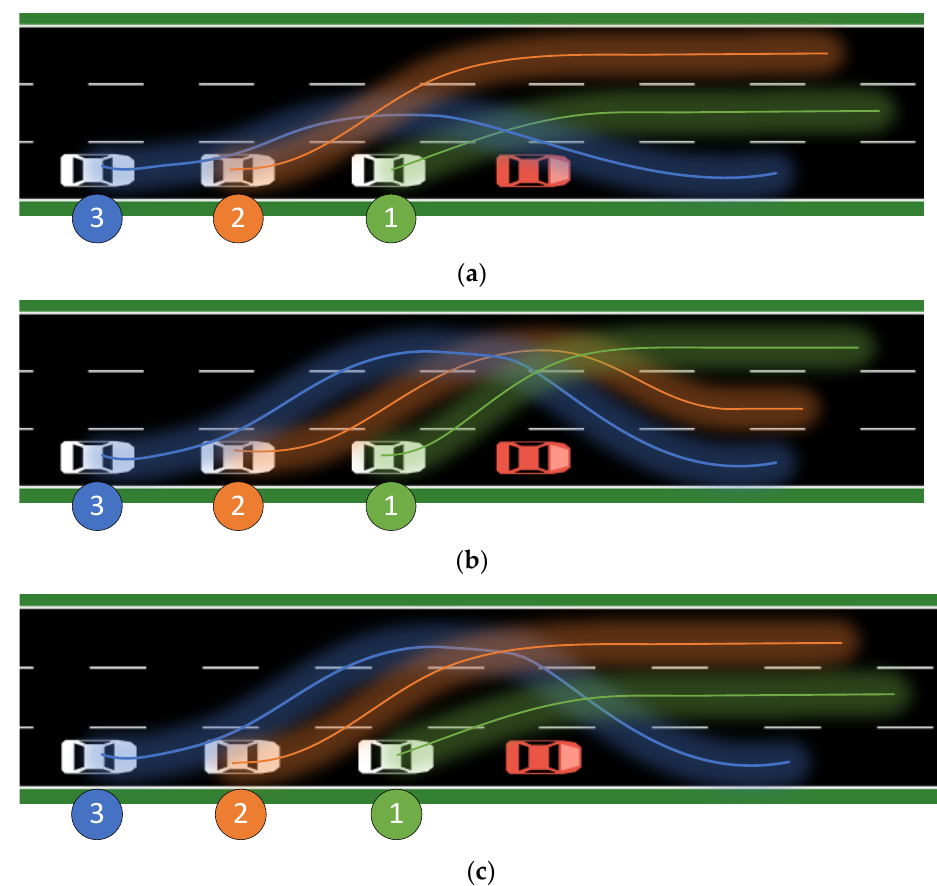
Figure 8. Results of agent training with large distance loss priority. Number of lane changes for vehicle 1, 2, 3: ( a ) 1, 2, 2; ( b ) 2, 3, 4; ( c ) 1, 2, 4.